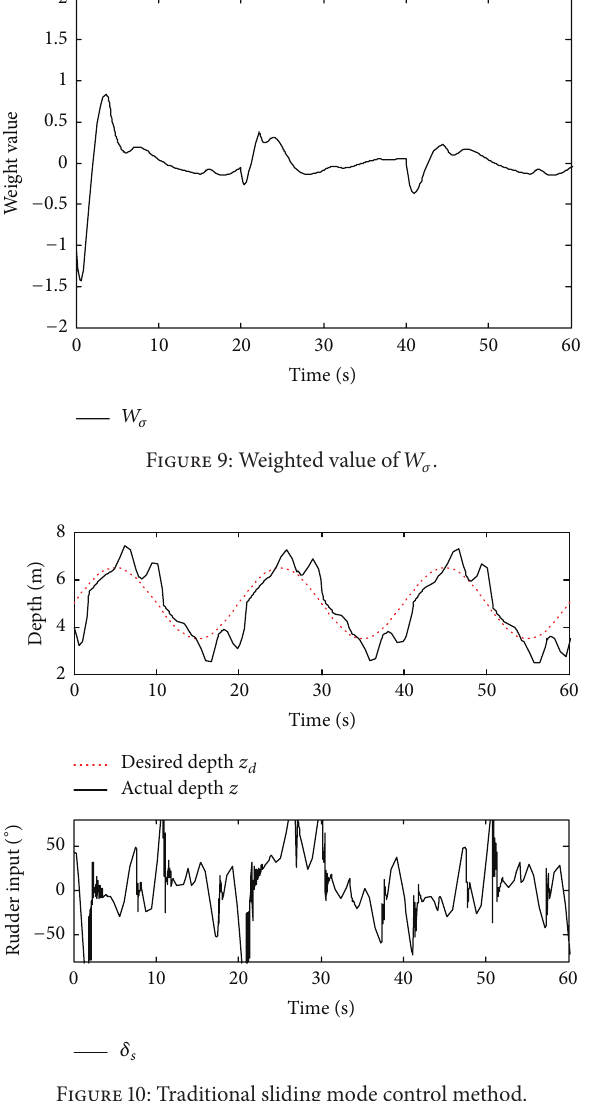
Figure 10: Traditional sliding mode control